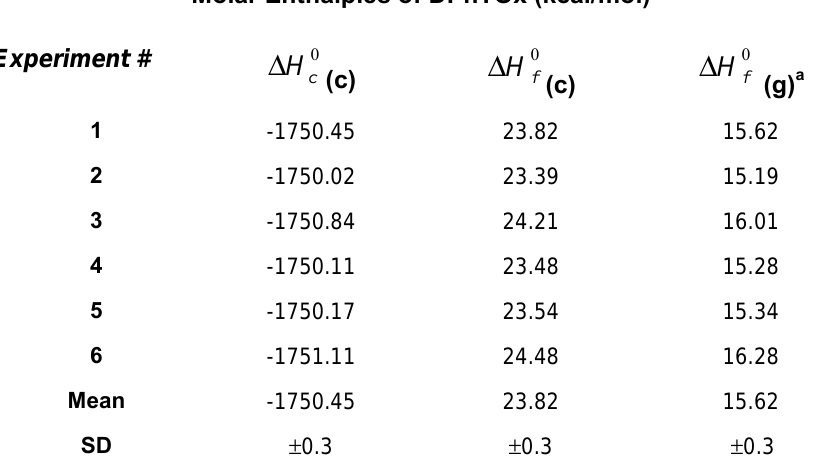
Molar Enthalpies of DPhTOx (kcal/mol)